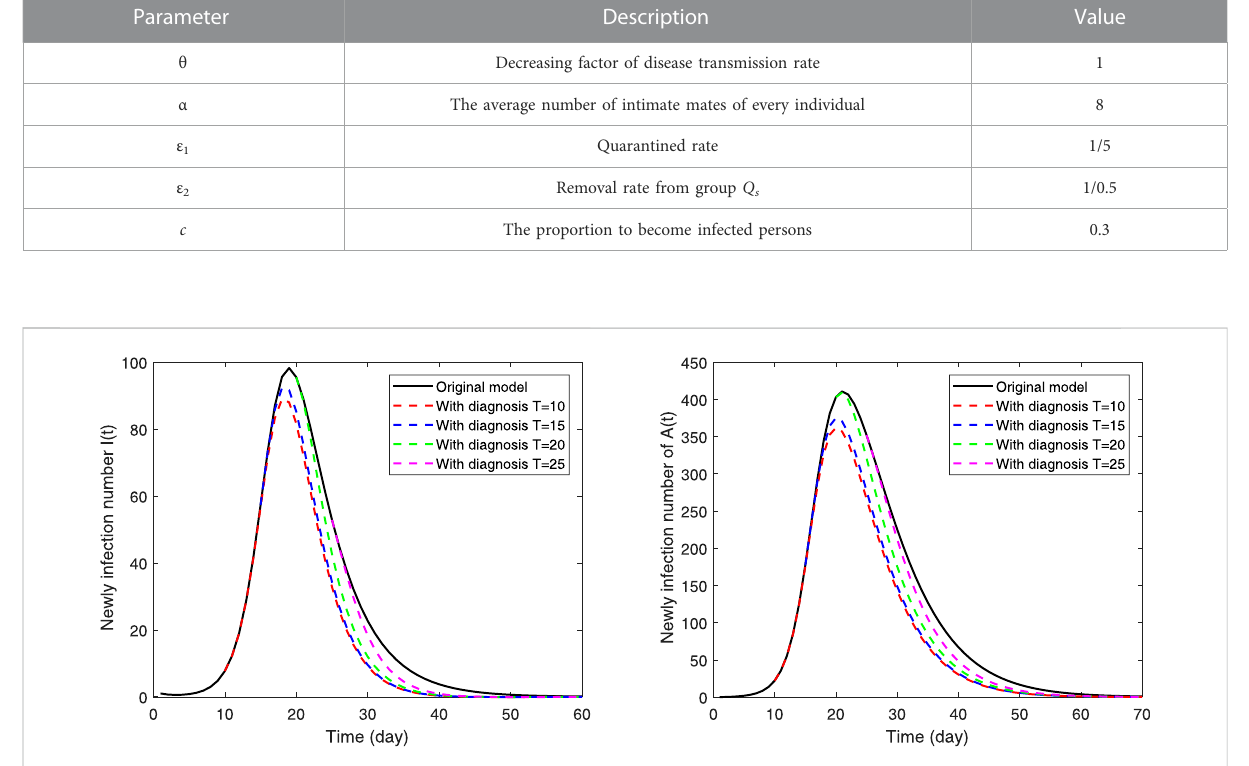
FIGURE 12 The impact of different intervention times on the epidemic. The black solid black line is the baseline, the left picture is the number of new symptomatic infections I ( t ),andtherightisthenumberofnewasymptomaticinfections A ( t ).Thereddashedlineindicatestheimplementationofthe intervention to quarantined suspected cases on the 10th day of the outbreak and the blue dashed line is on the 15th day. But the green and magenta